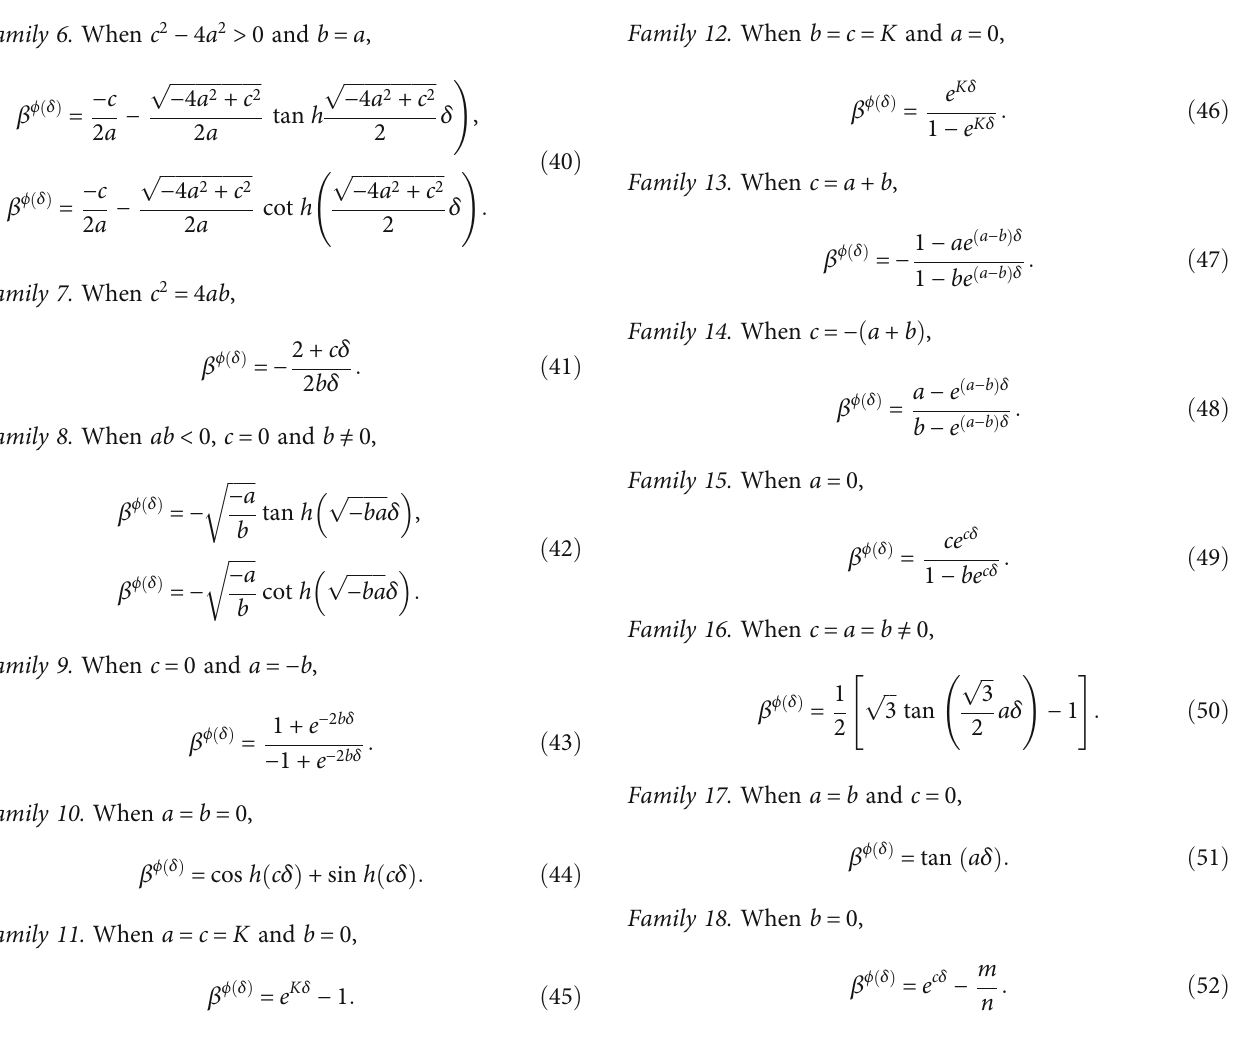
= 1 , S = − 1 , T = 2 , V = 1 , and γ = 0 : 5,0 : 7,0 : 9 for the solution described by Equation (22). (a) The 3D Figure 1: We consider κ = 2 , l = 1 , β 1 sketch of j u j 2 taking γ = 0 : 5 . (b) 2D-plot of j u j 2 with three distinct γ